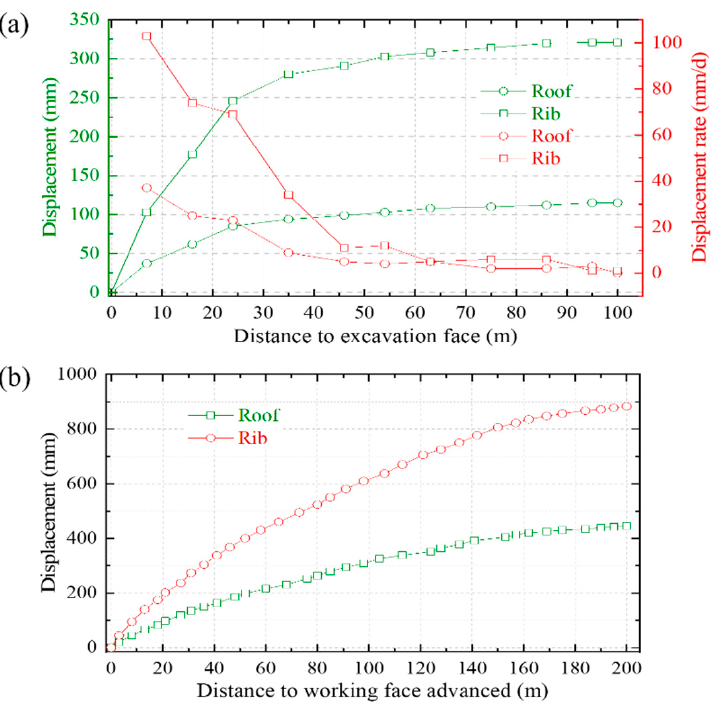
Figure 6. Monitoring data of roadway deformation under original support: ( a ) roadway deformation during tunneling and ( b ) deformation of roadway during mining of adjacent working face.